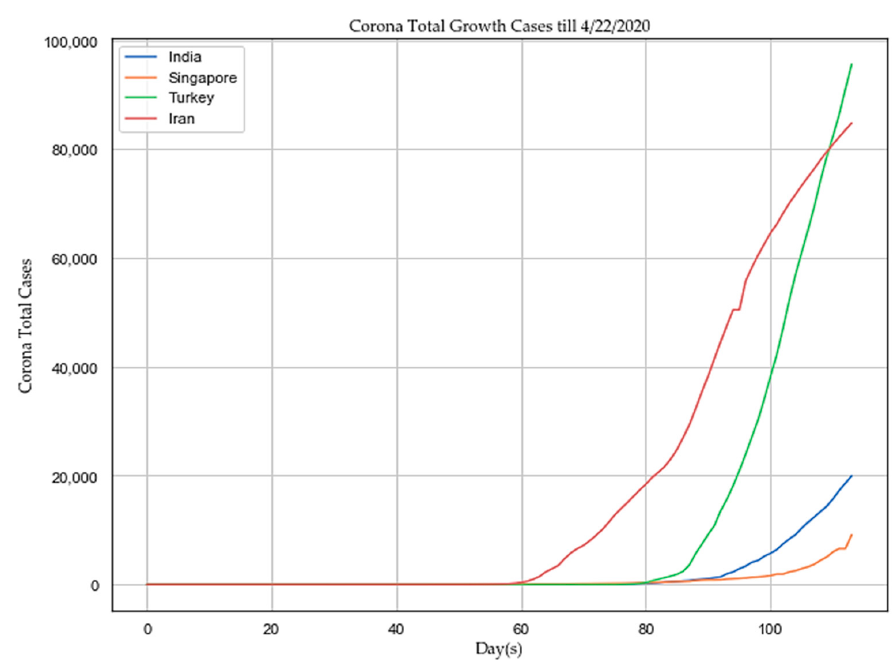
Figure 9. Trend analysis of total reported cases in four Asian countries.